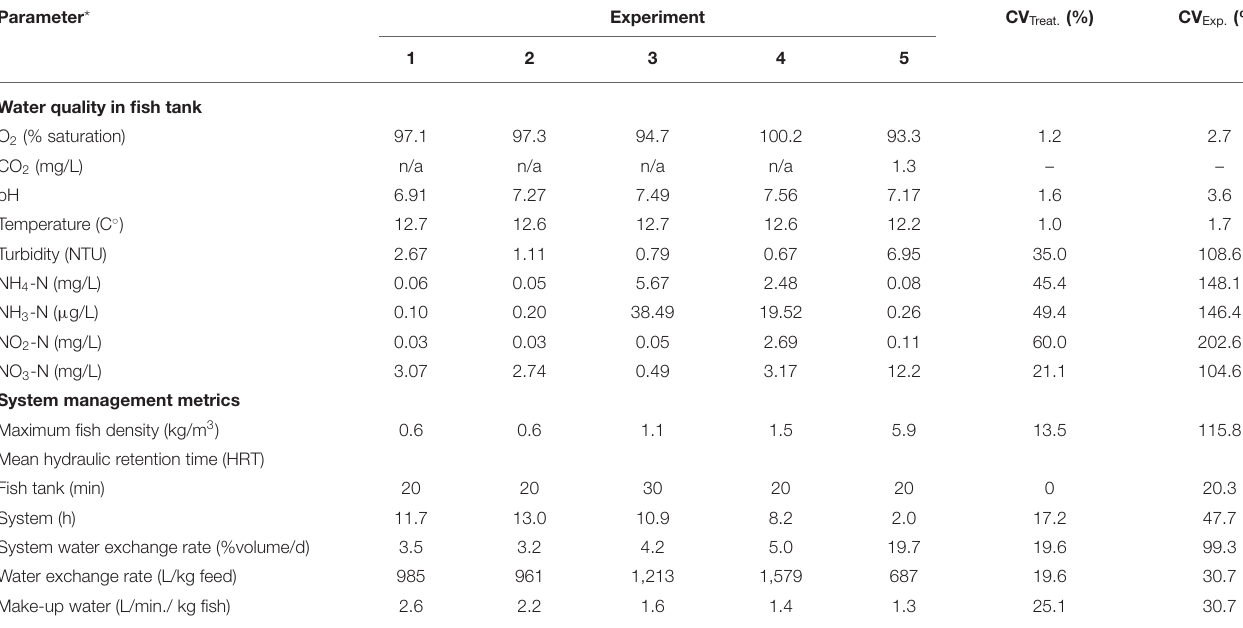
TABLE 2 | Water quality and system management metrics for the five experimental trials. Parameter * Experiment CV Treat. (%) CV Exp.